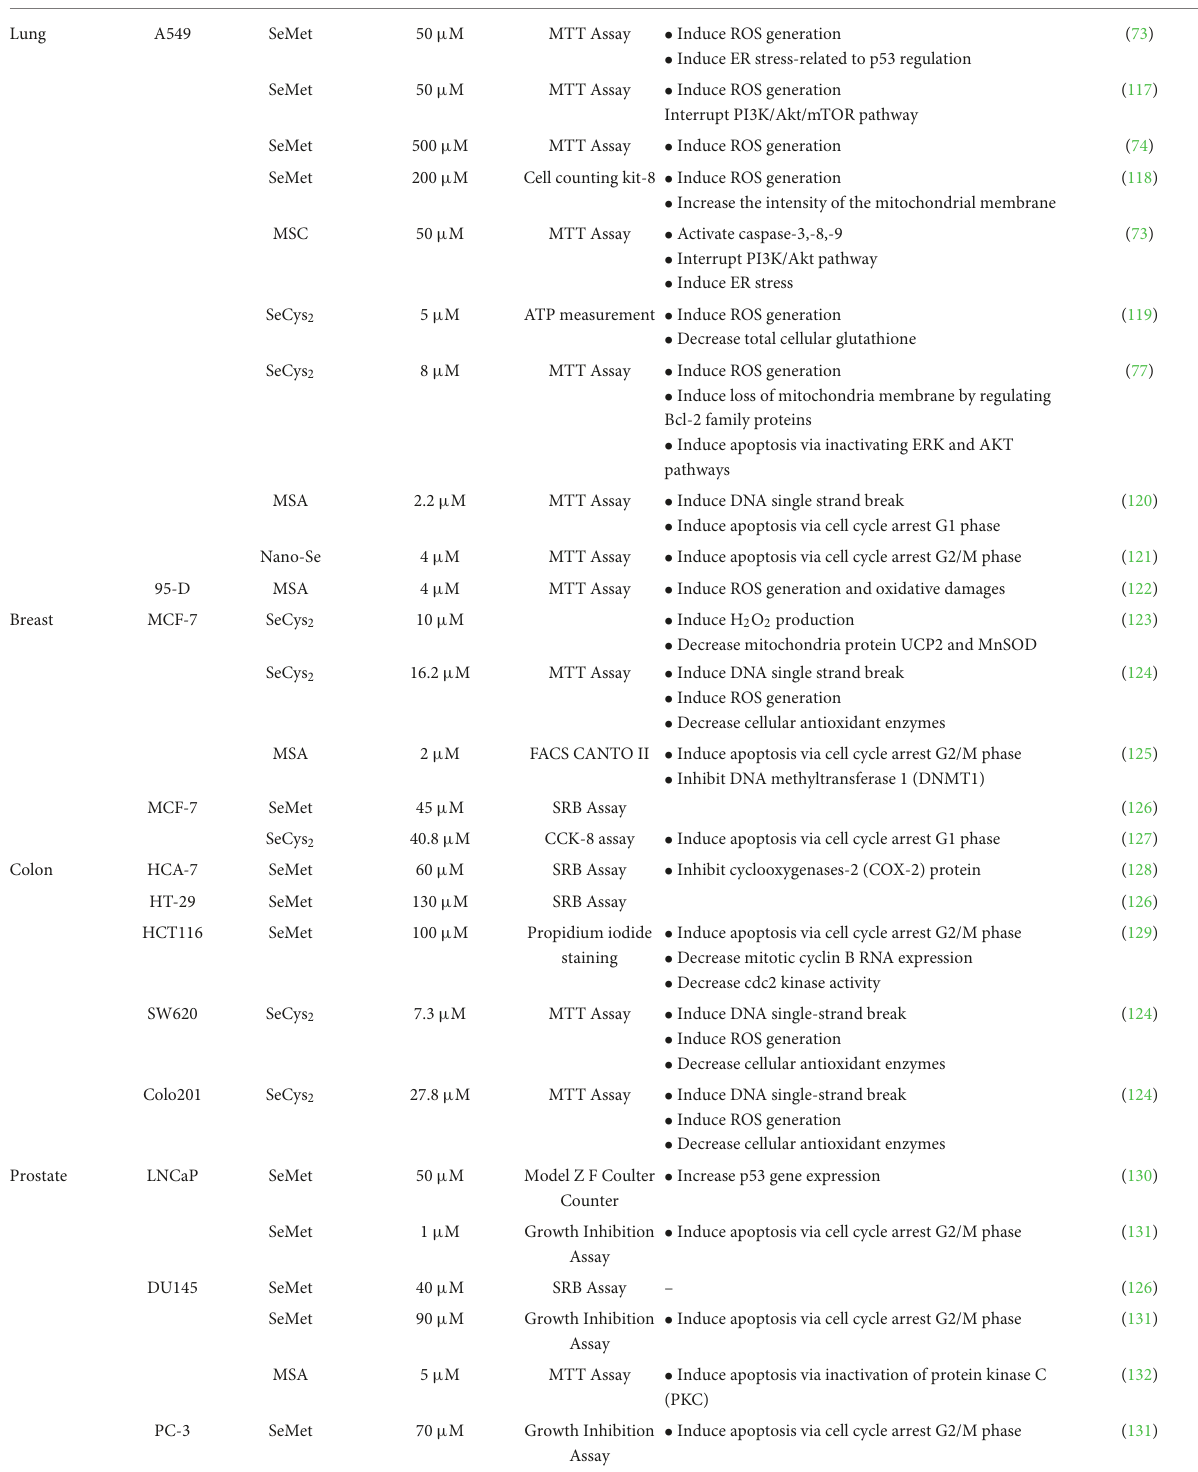
TABLE 1 Cytotoxicity of Se compounds against human cancer cell lines. Tumor